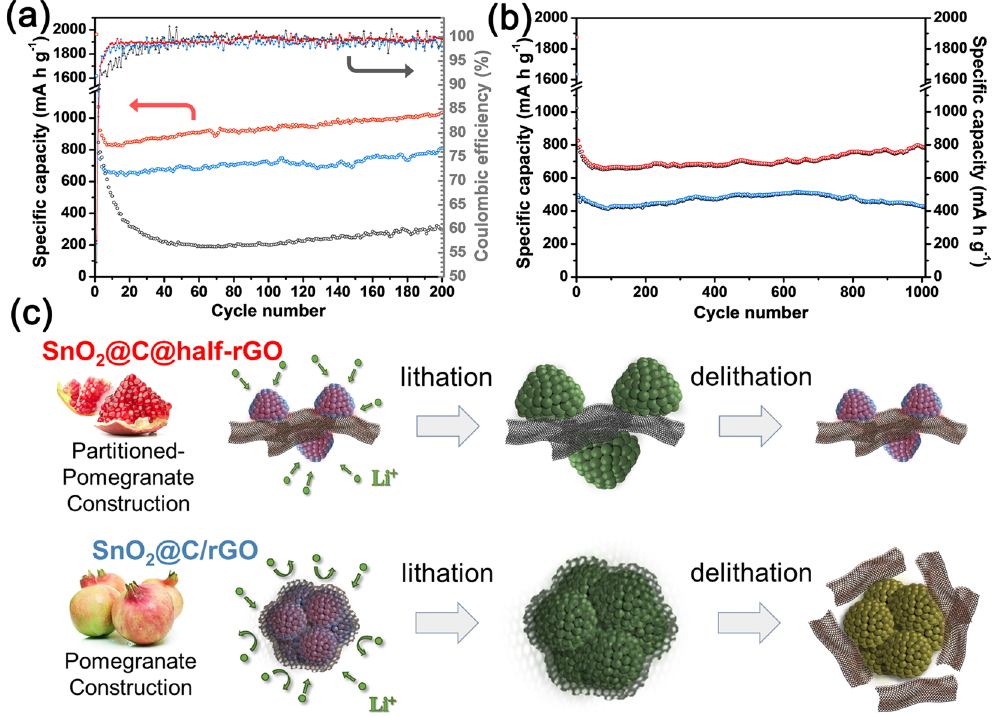
Figure 4. ( a ) Specific discharge capacity and coulombic efficiency of SnO 2 @C@half-rGO (red), SnO 2 @C/ rGO (blue) and SnO 2 /C (grey) at 100 mA g − 1 . ( b ) Specific charge and discharge capacity of SnO 2 @C@half-rGO (red) and SnO 2 @C/rGO (blue) at 1 A g − 1 . ( c ) Mechanism of the structure evolution of SnO 2 @C@half-rGO and SnO 2 @C/rGO during